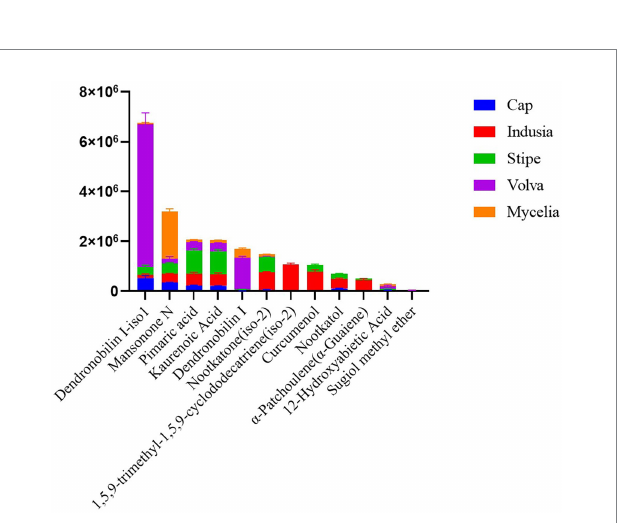
FIGURE 7 Distribution of terpenoids in different DI tissues. The abscissa represents the metabolite name, and the ordinate represents the peak area